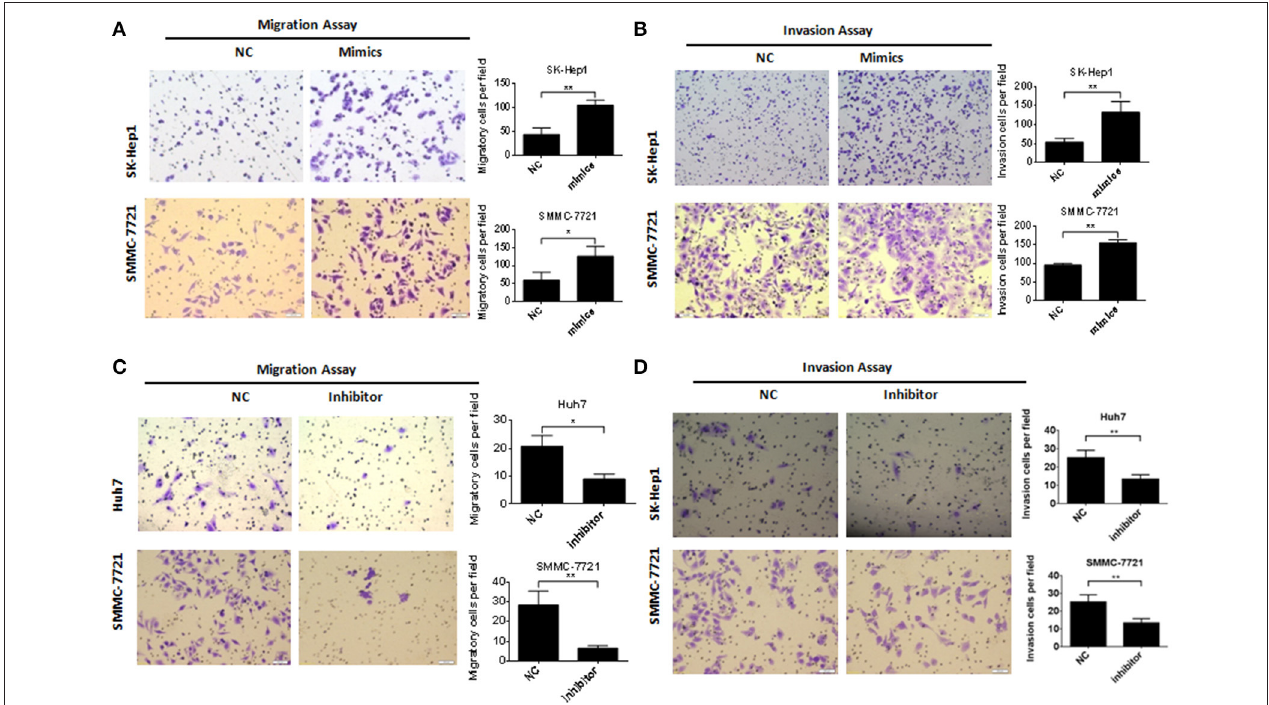
FIGURE 2 | miR-483-5p promoted HCC cells migration and invasion. (A) miR-483-5p mimics promoted HCC cells migration. (B) miR-483-5p mimics promoted HCC cells invasion. (C) miR-483-5p inhibitor suppressed HCC cells migration. (D) miR-483-5p inhibitor suppressed HCC cells invasion. * p < 0.05; ** p < 0.01 ×